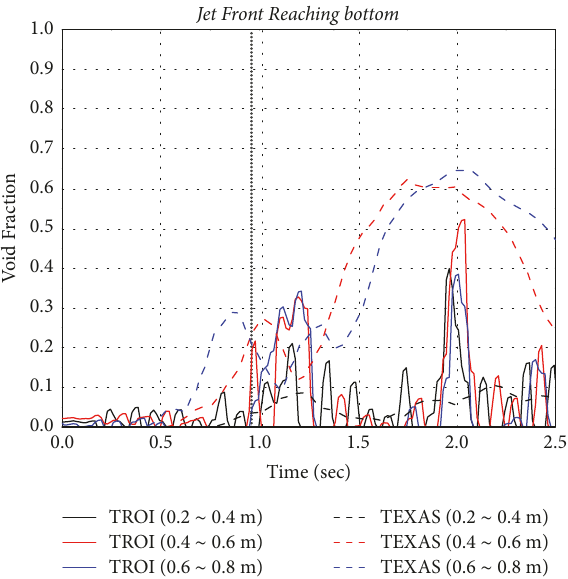
Figure 6: Void fractions in TROI experiment and TEXAS-V simulation for the partially flooded cavity condition.